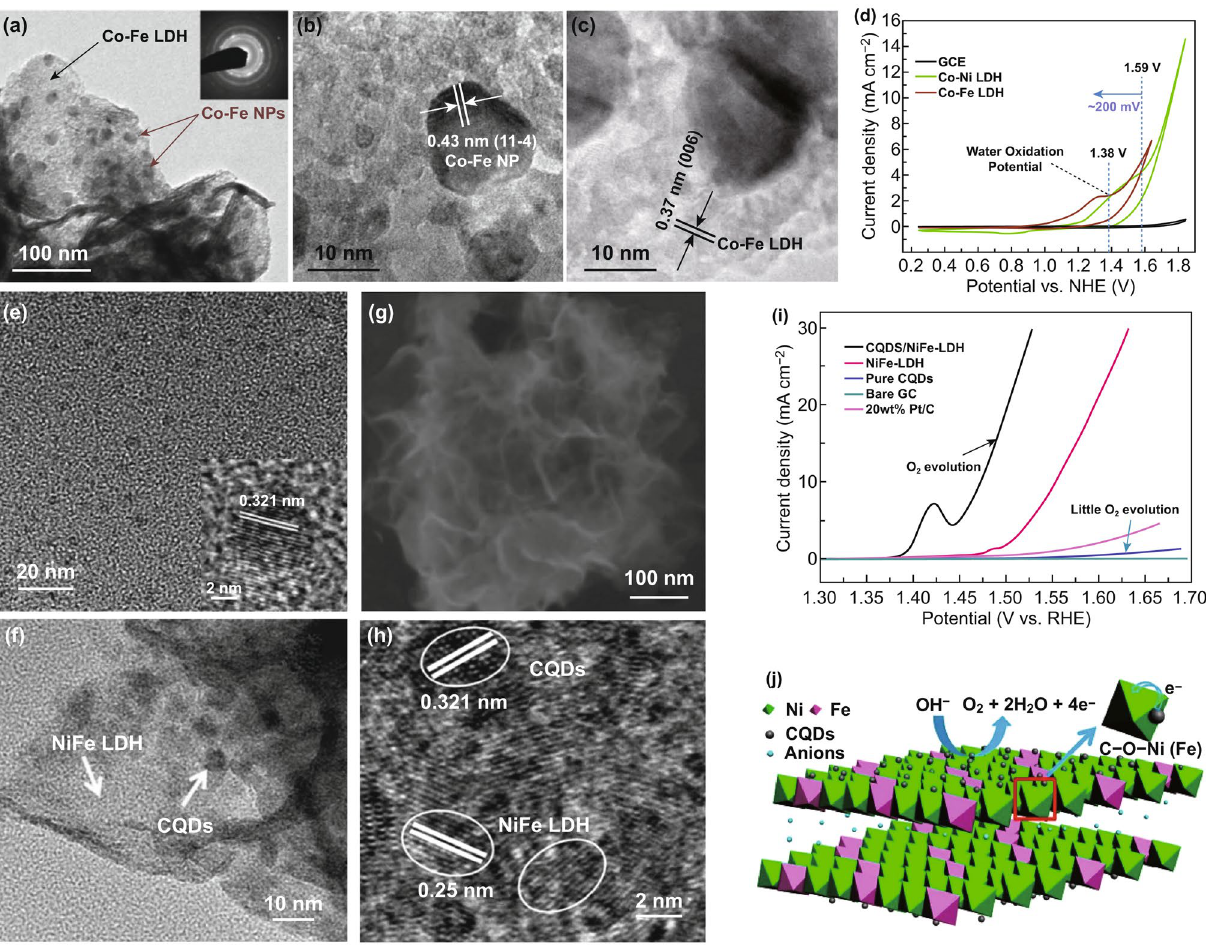
Fig. 8 a TEM and SAED images (inset of a ), b and c HRTEM images of Co–Fe LDH decorated with Co–Fe hydroxide NPs. d CV curves of the three catalysts at 20 mV s −1 in 0.1 M phosphate buffer. Reproduced with permission of Ref. [100]. Copyright 2015 The Electrochemical Society. e TEM image and HRTEM image (inset of e ) of CQD. f TEM image, g SEM image, h HRTEM image of the CQD/NiFe LDH hybrid. i LSV curves of as‑prepared catalysts at 5 mV s −1 in 0.1 M KOH. j Schematic model of the roles of CQDs in the CQD/NiFe LDH hybrid catalyst. Reproduced with permission of Ref. [101]. Copyright 2014 American Chemical